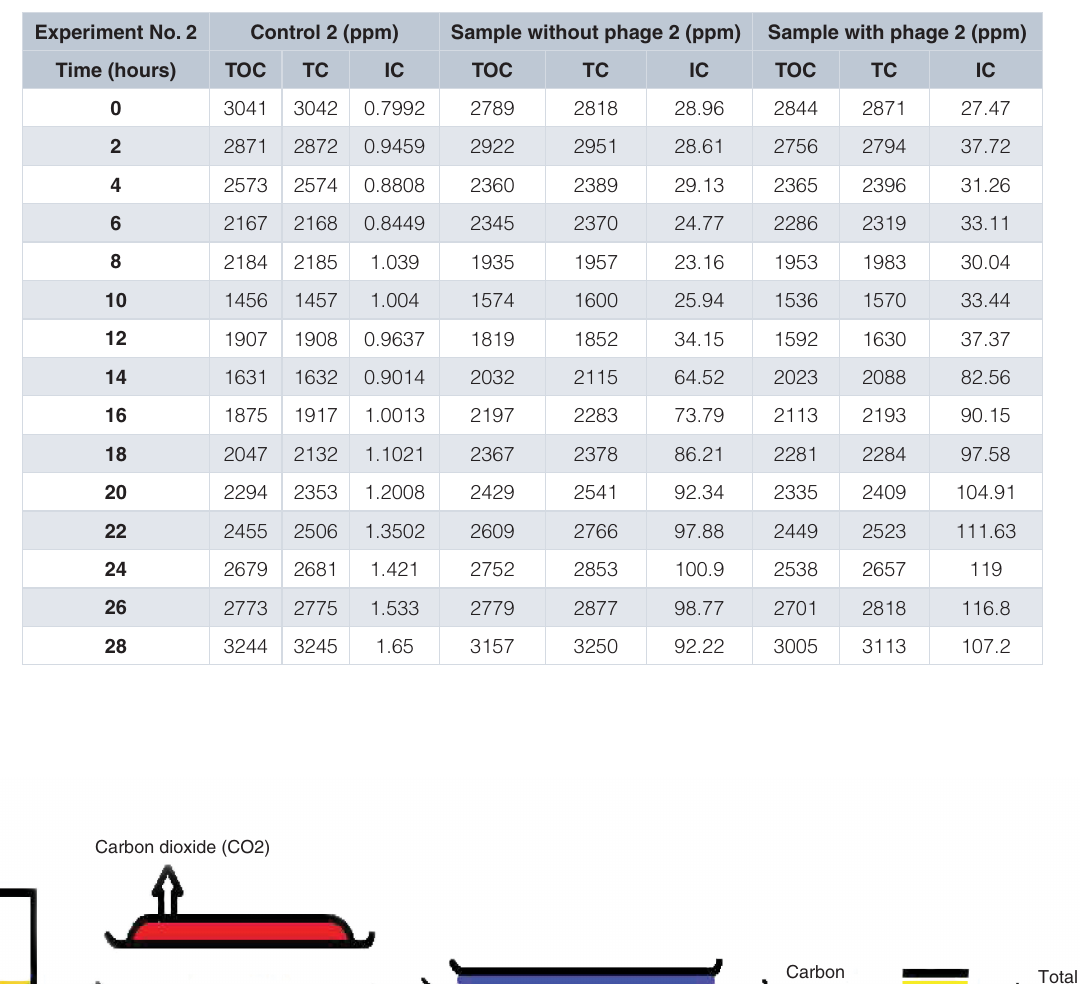
Table 2. TOC analysis results of control and bacterial samples (with and without phage).